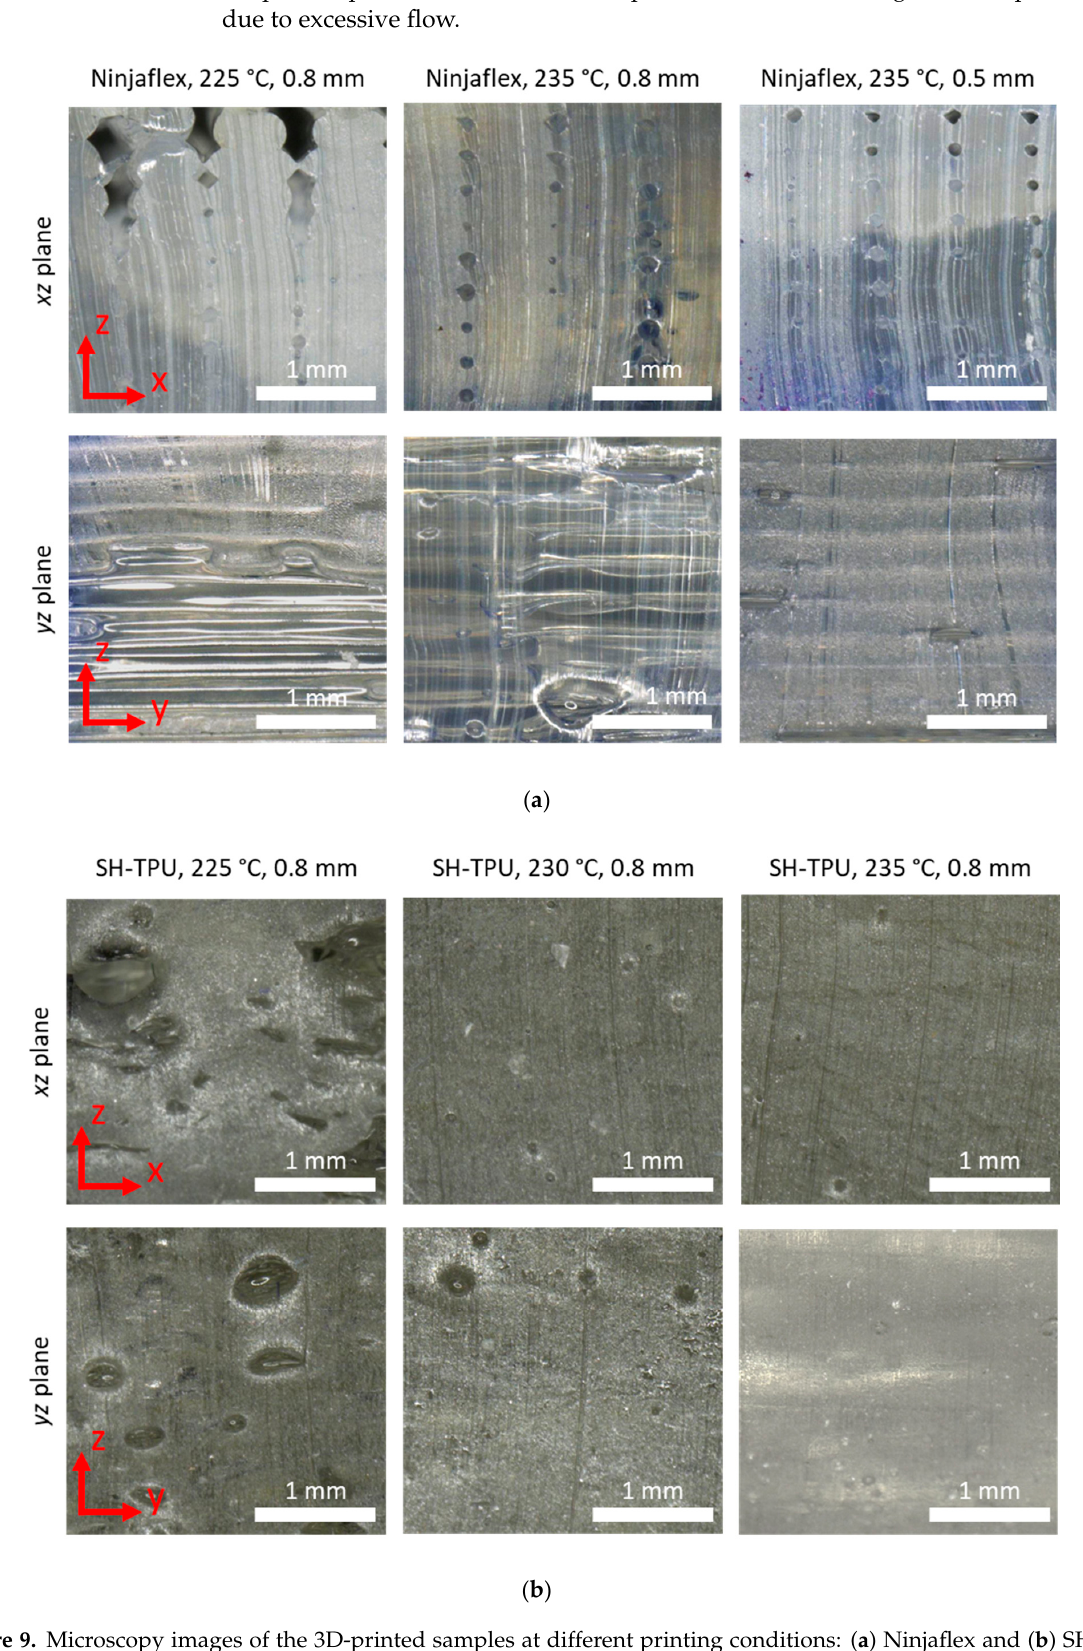
Figure 9. Microscopy images of the 3D-printed samples at different printing conditions: ( a ) Ninjaflex and ( b ) SH-TPU. The xz -plane shows defects in between filament planes, and the yz -plane shows defects between filament rows.